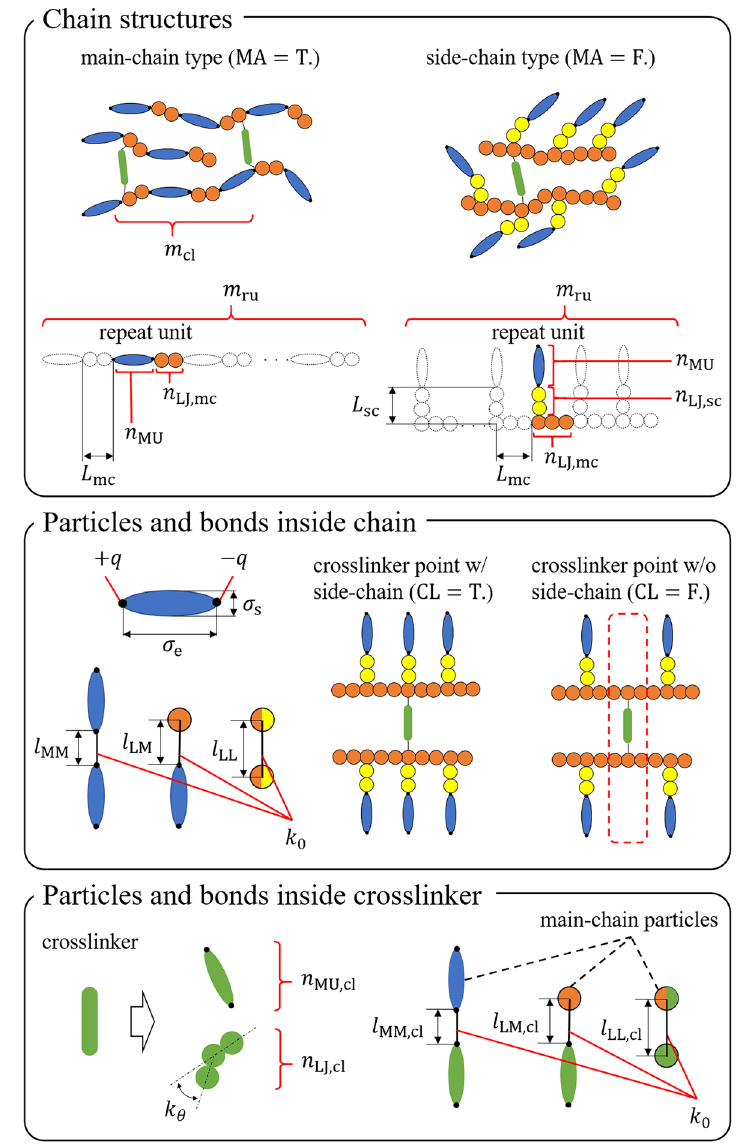
Figure 1. Schematic illustration of the design variables for LCE molecular architectures. Mesogenic units in chains are marked as blue ellipsoids, Lennard–Jones (LJ) particles in main chains are marked as orange circles, LJ particles in side chains are marked as yellow circles, mesogenic units in crosslinkers are marked as green ellipsoids, and LJ particles in crosslinkers are marked as green